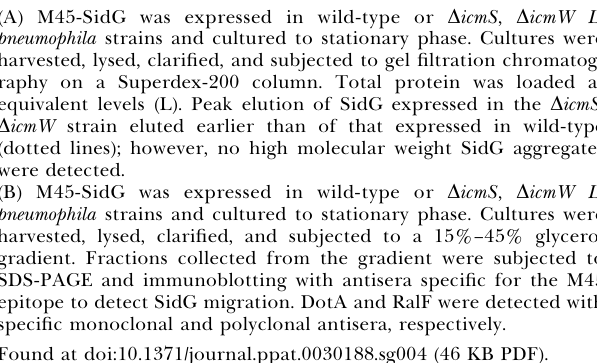
Figure S4. SidG Does Not Form Aggregates When Expressed in D icmS , D icmW L. pneumophila